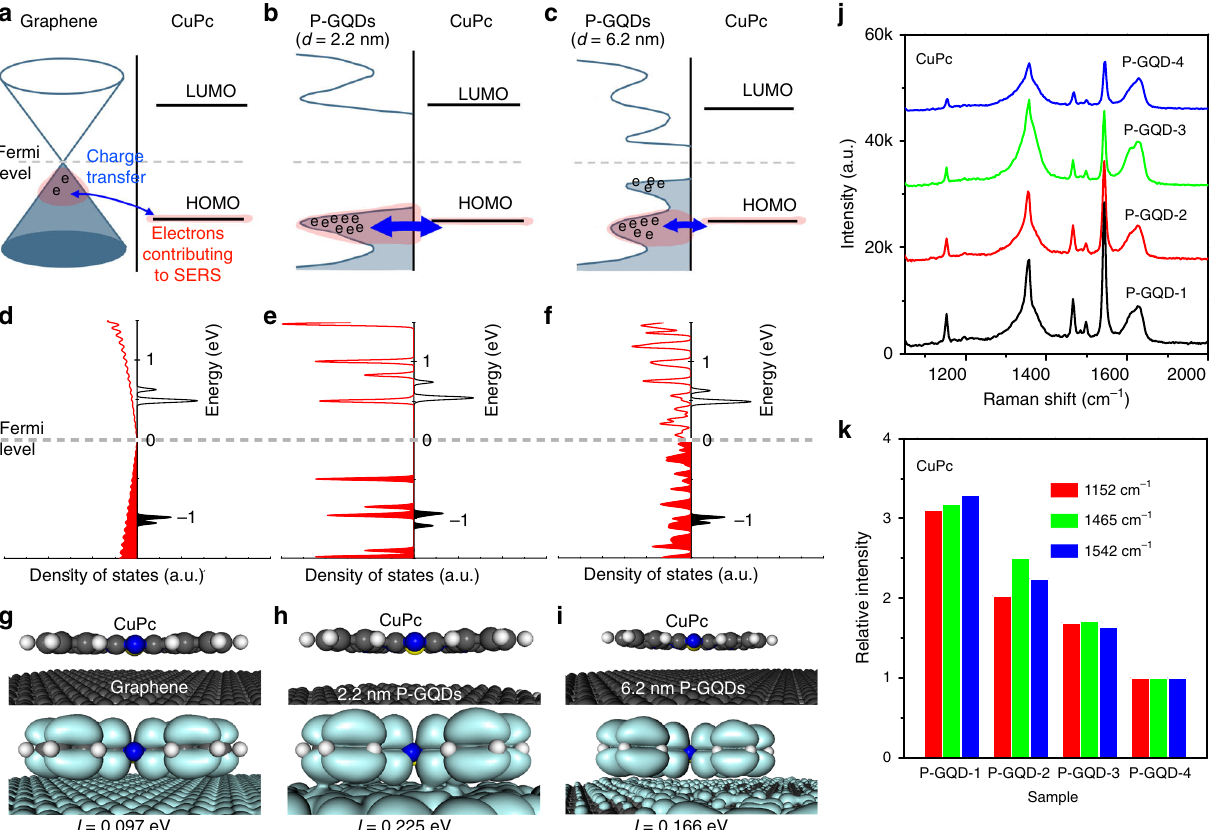
Fig. 5 The size-dependent Raman enhancement for CuPc. a – c The ground state charge transfer between CuPc and graphene, GQDs (2.2 nm) or GQDs (6.2 nm). The electron states in the CuPc/graphene (or GQD) system, which have the possibility to contribute to the SERS, are marked by red shadows. d – f The calculated DOS and g – i the calculated molecular orbital (at the HOMO level of CuPc) of CuPc/graphene, CuPc/GQDs (2.2 nm), and CuPc/GQDs (6.2 nm), respectively. ( g – i ) The atomic models used in the density functional theory (DFT) calculations and the calculated charge transfer integrals ( I ). j Raman spectra of thermally evaporated CuPc on P-GQDs with different sizes. k Relative intensity of the characteristic peaks of CuPc on P-GQDs with different sizes, normalized to the signals on P-GQD-4. The largest enhancement of CuPc signal occurs on